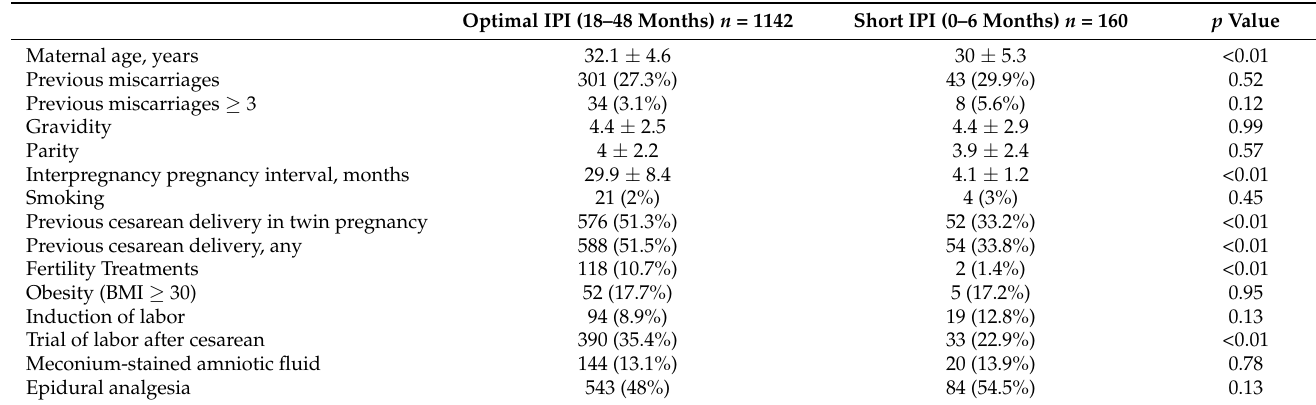
Table 1. Characteristics of women, pregnancies, and deliveries in the